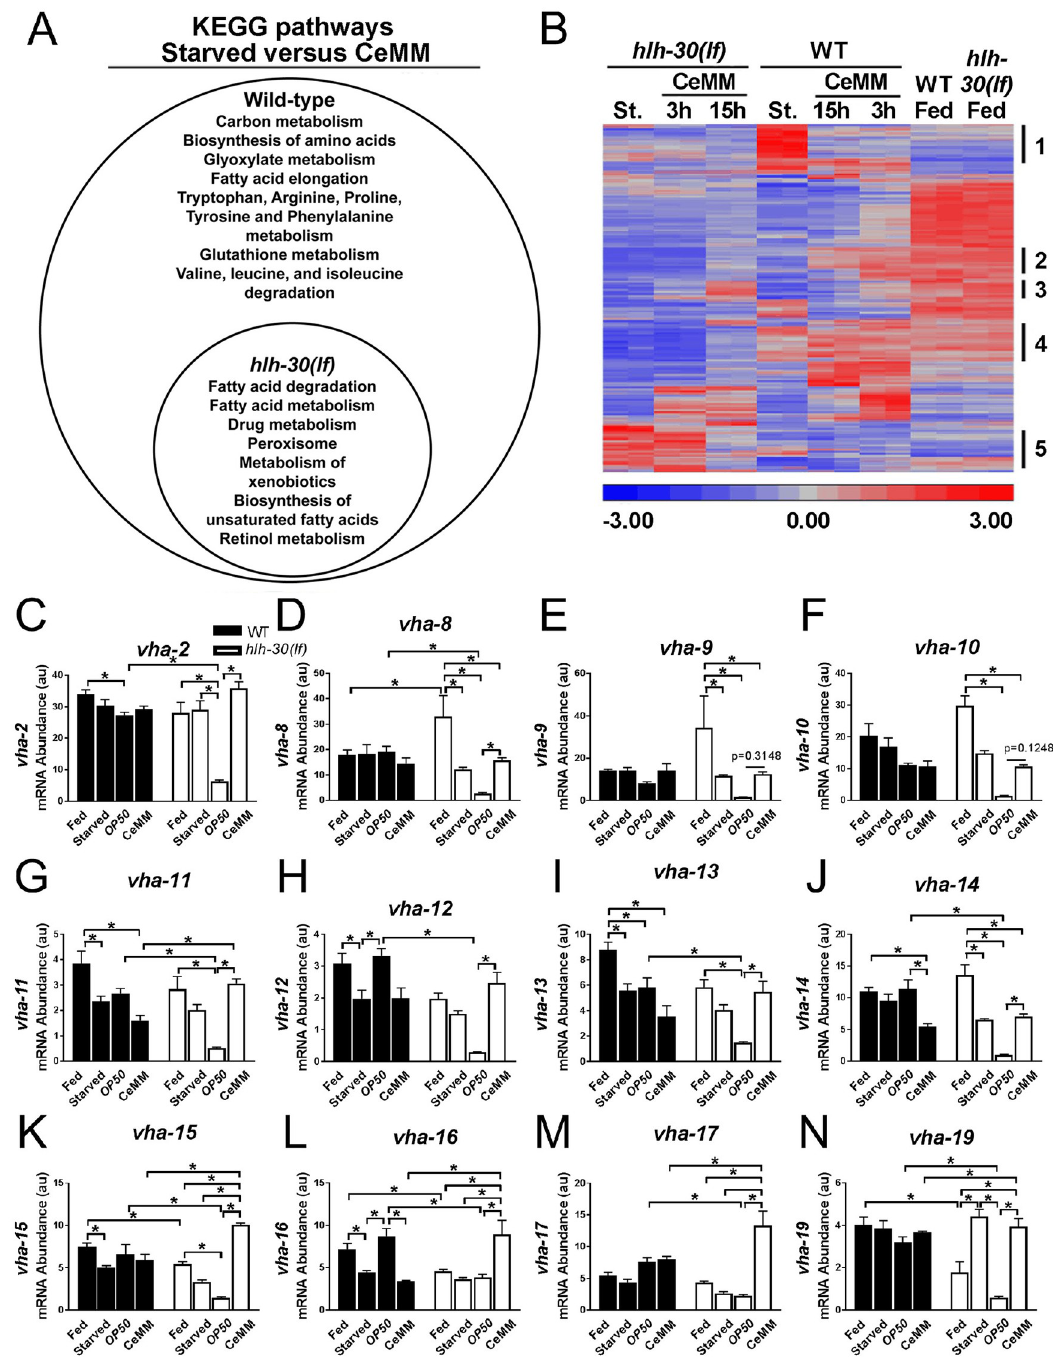
Fig 5. CeMM restored expression of vha genes in starved hlh-30(lf) mutants. (A) Venn diagram depicting significantly regulated KEGG pathways (both up-regulated as well as down-regulated; see S5 Table for details) by RNAseq analysis in WT and hlh-30(lf) L1 worms starved for 33 hours followed by incubation in CeMM for 0 or 15 hours versus starved worms in respective groups. N = 2 biological replicates/group. (B) Unsupervised hierarchical clustering of significantly altered transcripts in WT and hlh-30(lf) L1 worms starved for 33 hours followed by incubation in CeMM for 0, 3, or 15 hours or their fed counterparts. N = 2/group. Lists of genes in rows marked as 1–5 are presented in S5 Table. (C–N) mRNA abundance in au with values normalized to the control gene ama-1 determined by qPCR for genes encoding for proton pump subunits (as named) in L1 stage WT and hlh-30(lf) animals in the fed state (fed), after starvation for 33 hours (starved), and after starvation for 33 hours followed by refeeding on E . coli OP50 or CeMM for 15 hours. N = 3–8 biological replicates/group. Bars indicate mean ± SEM. � P < 0.05 by post hoc test after